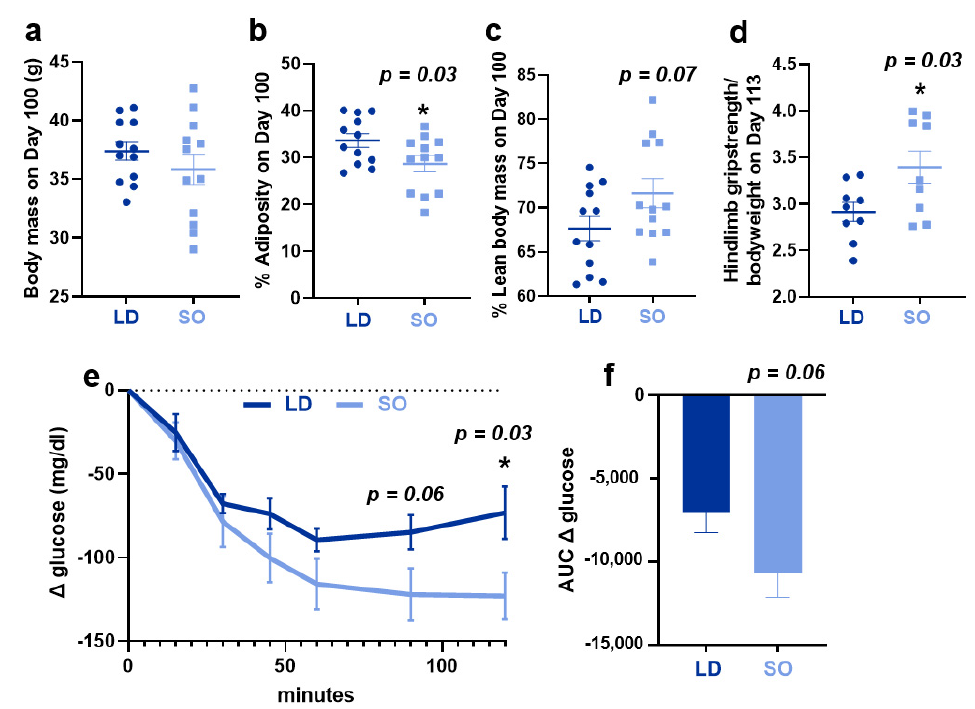
Figure 2. Physiological parameters of mice consuming LD and SO diets for 14–18 weeks. ( a ) Body mass on Day 100 of the study, prior to necropsy. ( b ) Percent adiposity as measured by EchoMRI on day 100. ( c ) Percent lean body mass as measured by EchoMRI on day 100. ( d ) Hindlimb grip strength as measured by Grip Strength Meter on Day 113. ( e ) On day 85, mice were given a bolus of 0.75 U/kg of insulin injected intraperitoneally, blood glucose was measured over a period of 120 min, and ( f ) the area under the curve for glucose clearance was computed. Data are expressed as individual values and the graph displays the mean +/ − SEM. Two-sample t -tests were used to determine significant differences between diet groups. For all statistical analyses, an asterisk (*) designates significance with p < 0.05, while the absence of asterisks indicates that the p -value was nonsignifi- cant. The p -values < 0.10 are listed in each figure. N = 9–12/group.